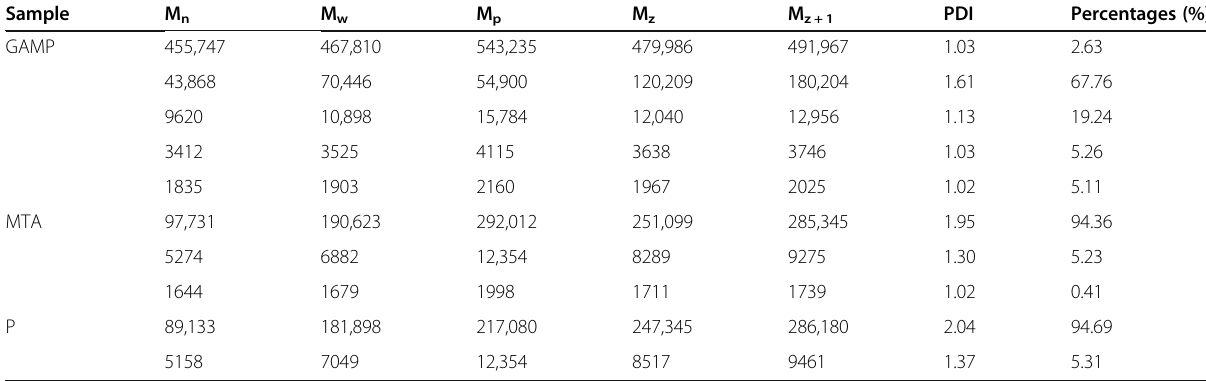
Table 2 GPC results of GAMP, MTA and P Sample